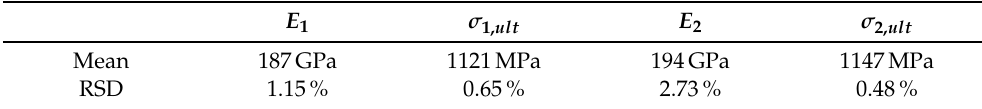
Table 3. Results of tensile tests on the 1.4310 steel are given as the mean value and the relative standard deviation. The direction of rolling of the steel material is indicated by index 1, while index 2 denotes the transverse direction. E 1 σ 1, ult E 2 σ 2, ult Mean 187GPa